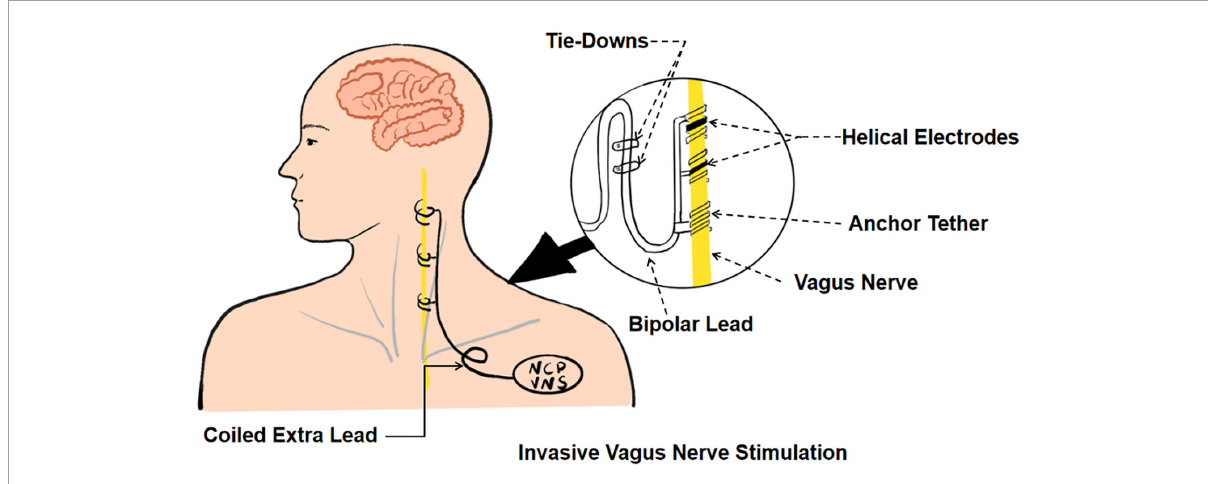
FIGURE1 The schematic of invasive vagus nerve stimulation.